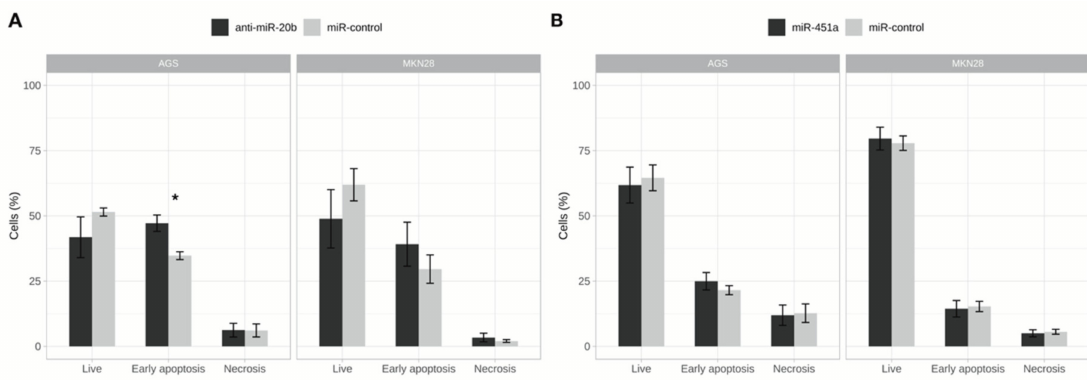
Figure 6. Exogenously altered expression of miR-20b e ff ected proportion of cells undergoing process of early apoptosis. ( A ) Changes of apoptosis rates in AGS and MKN28 cell cultures after inhibition of miR-20b. Proportion of early apoptotic cells increased statistically significantly in AGS cells line (* p < 0.05); ( B ) Changes of apoptosis rates in AGS and MKN28 cell cultures after increased expression of miR-451a. Data from three independent experiments.